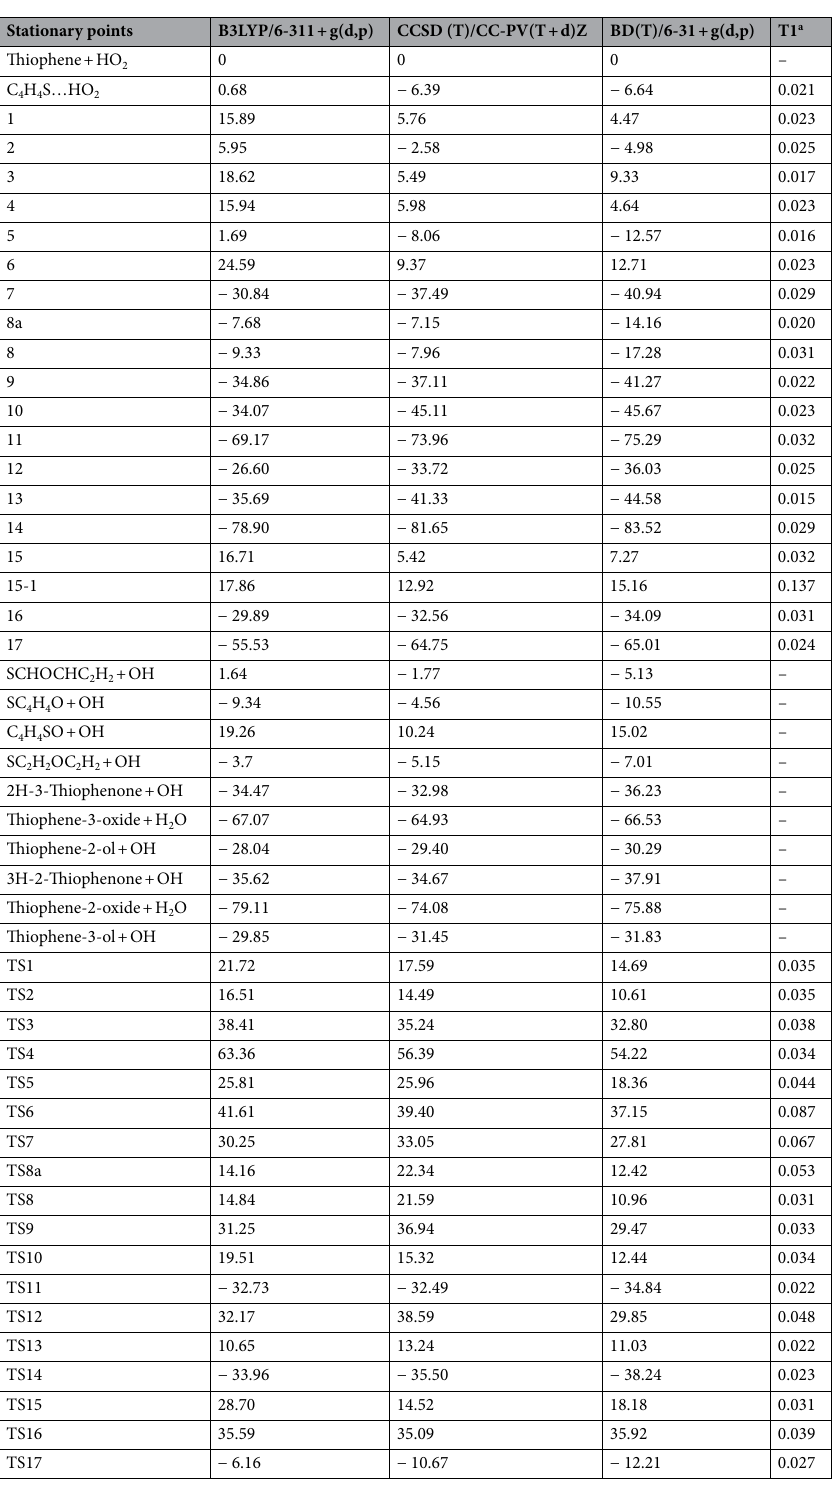
Table 1. Calculated relative energies (in kcal mol −1 ) of the reactants, products, intermediates, and transition states at three different methods. a Computed T1 diagnostic values at the CCSD (T)/CC-PV(T + d)Z